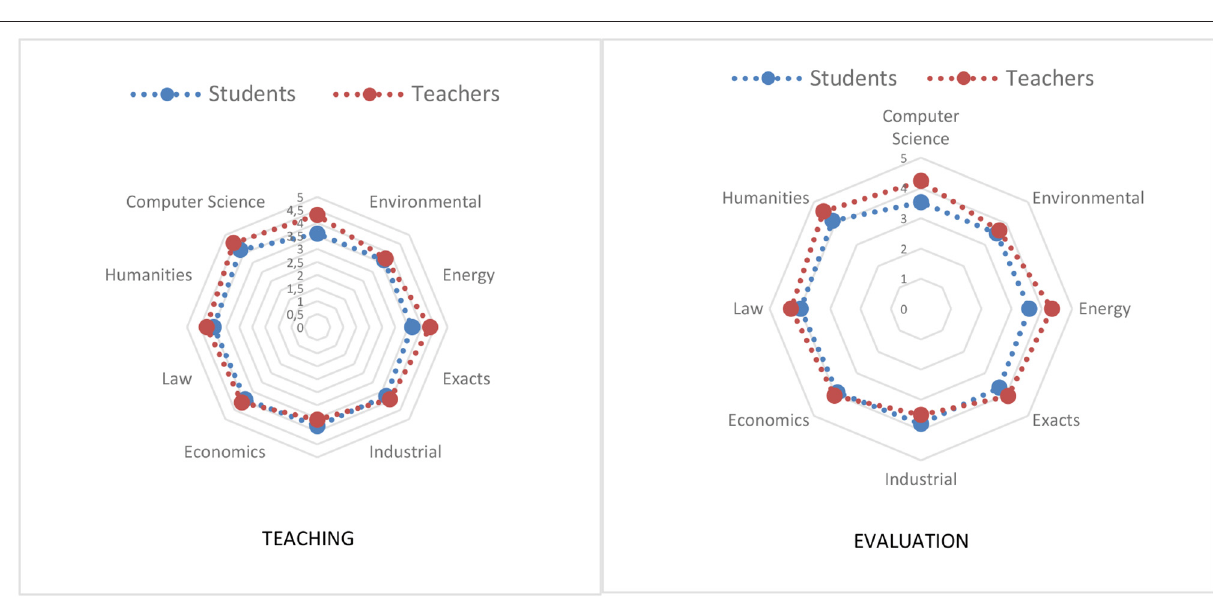
FIGURE 2 | Use of the cognitive strategy for teaching and evaluation